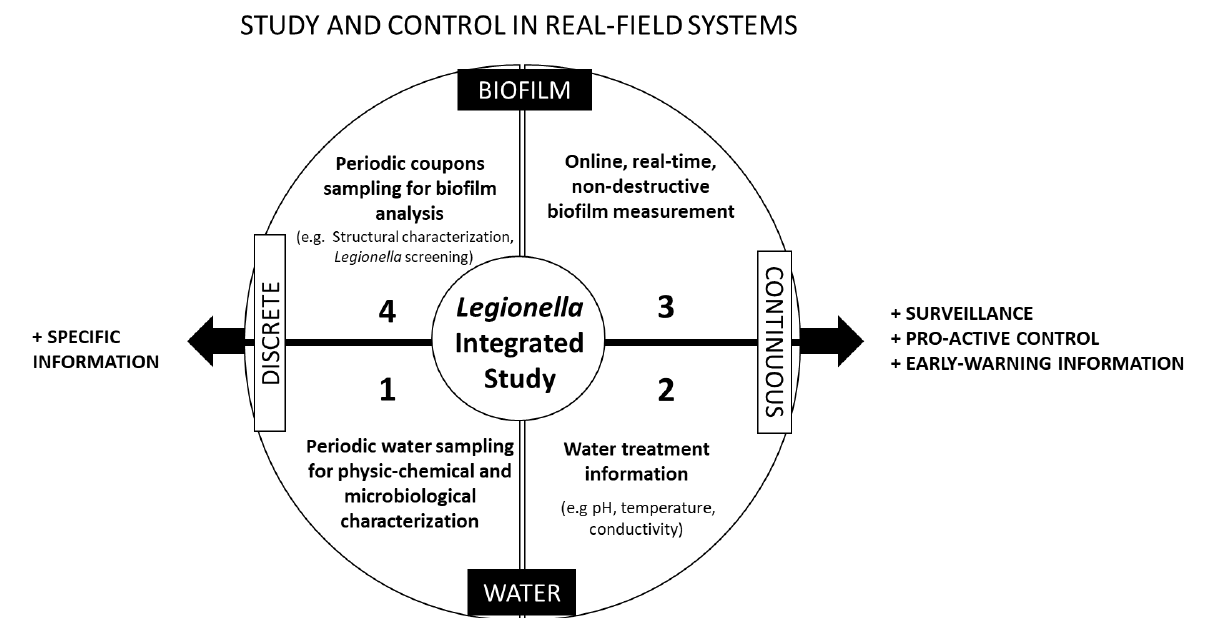
Figure 1. Integrated monitoring conceptual model for Legionella study and control in field-based systems. The model proposes four complementary sets of information: water (1 and 2) and biofilm (3 and 4) monitoring, discretely sampled (1 and 4) and continuously measured (2 and 3). Continuous information will enhance pro-active control and surveillance, based on early-warning information, while discrete information will allow to gain more specific information about Legionella ecology.